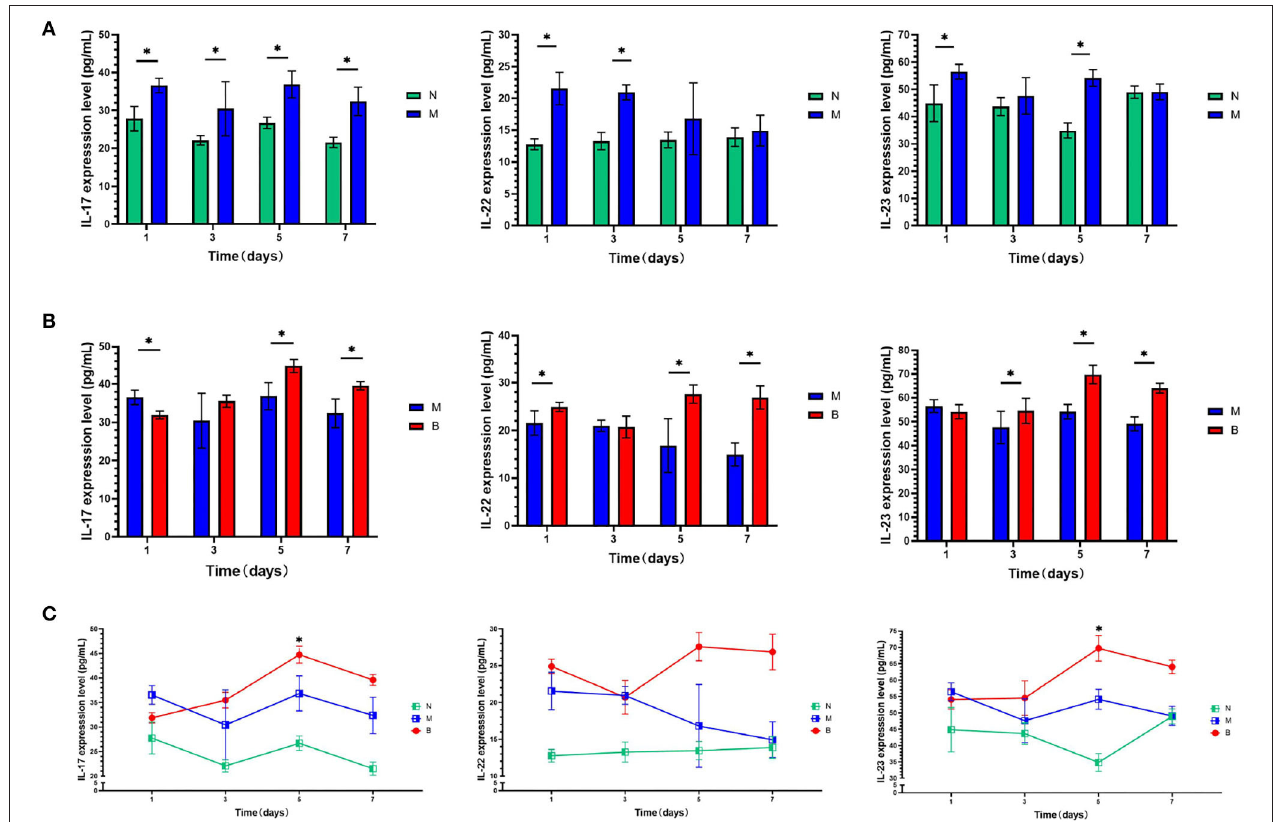
FIGURE 1 | (A) On days 1,3, 5, and 7, serum levels of cytokines of the blank group (N) and control group (M) were compared. (B) On days 1, 3, 5, and 7, serum levels of cytokines of the control group (M) and the experimental group (B) were compared. (C) On days 1,3, 5, and 7, serum levels of cytokines in the same group were compared.* P < 0.05.